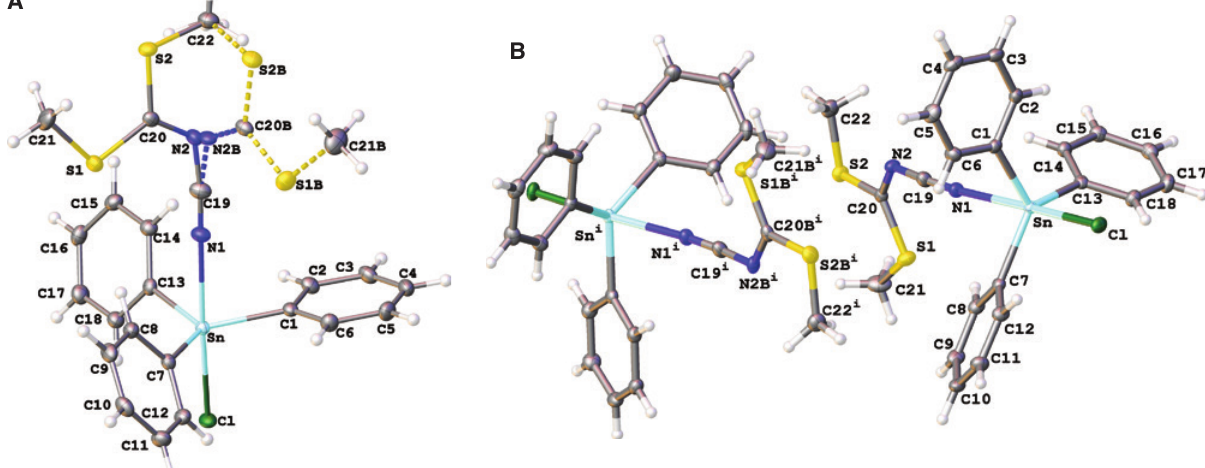
SnNCNC(SCH ) ] ( 1 ) showing 30% probability ellipsoids and the crystallographic numbering 3 3 2